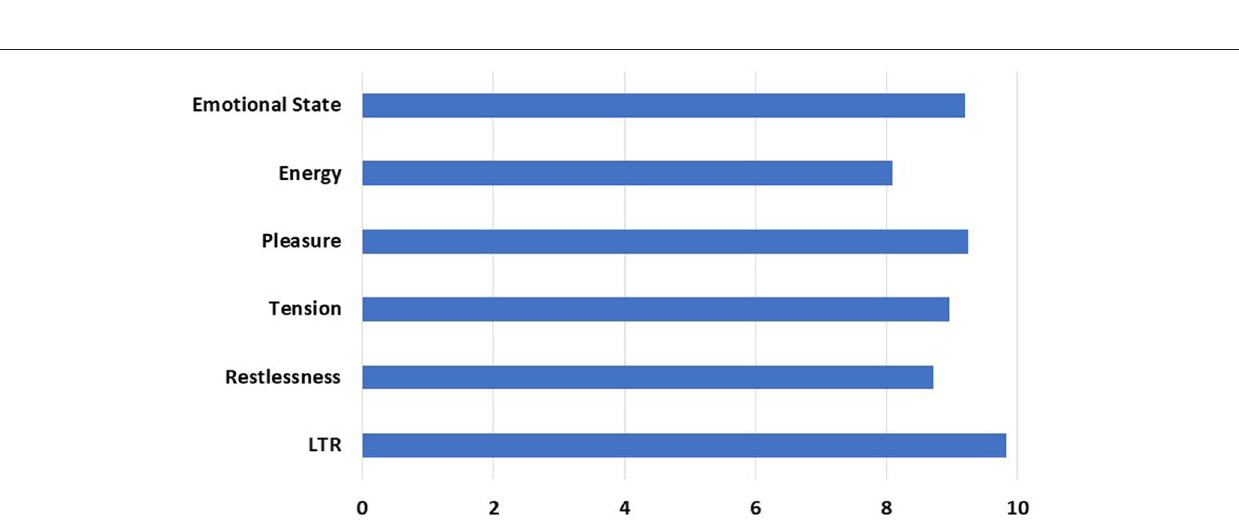
FIGURE 5 | Post-intervention Responses Elicited by Survey. The X-axis represents average Likert scale rating by patients (1–10). Y-axis represents questions asked to measure the effect of the intervention. Patients were assessed for positive change in emotional state, increase in energy level, feelings of pleasure, reduction of tension, and restlessness. LTR, Likelihood to Recommend to